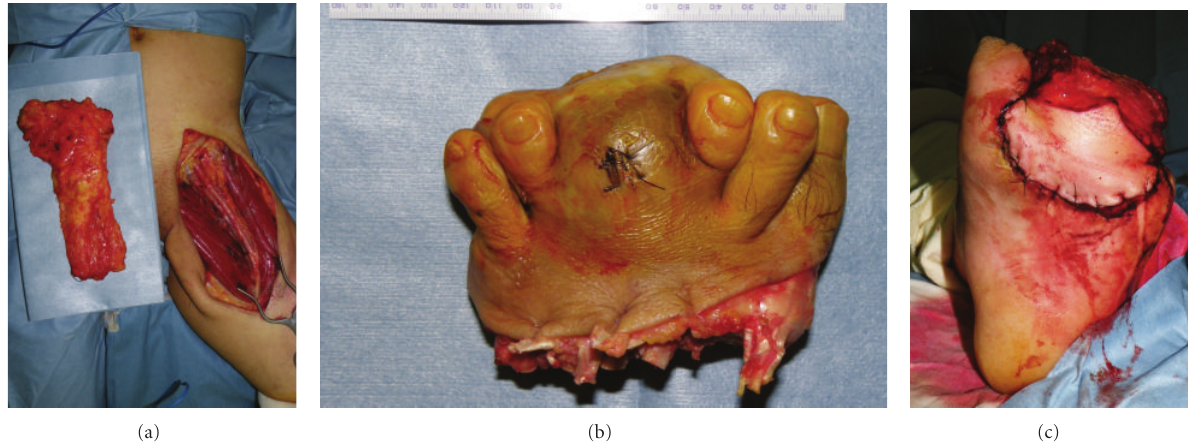
Figure 3: Intraoperative views of ablative surgery and secondary reconstructive surgery. (a) Ipsilateral inguinal dissection at the first operation. (b) Wide excision of the primary lesion with a 30 mm surgical margin. (c) Free latissimus dorsi musculocutaneous flap transfer to the amputated stump.